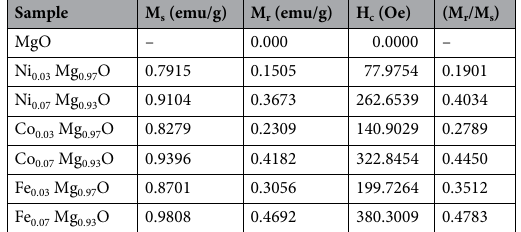
Table 3. Variations of Ms, Mr, Hc, and Mr/Ms of Ni, Co, and Fe-doped MgO nanoparticles.